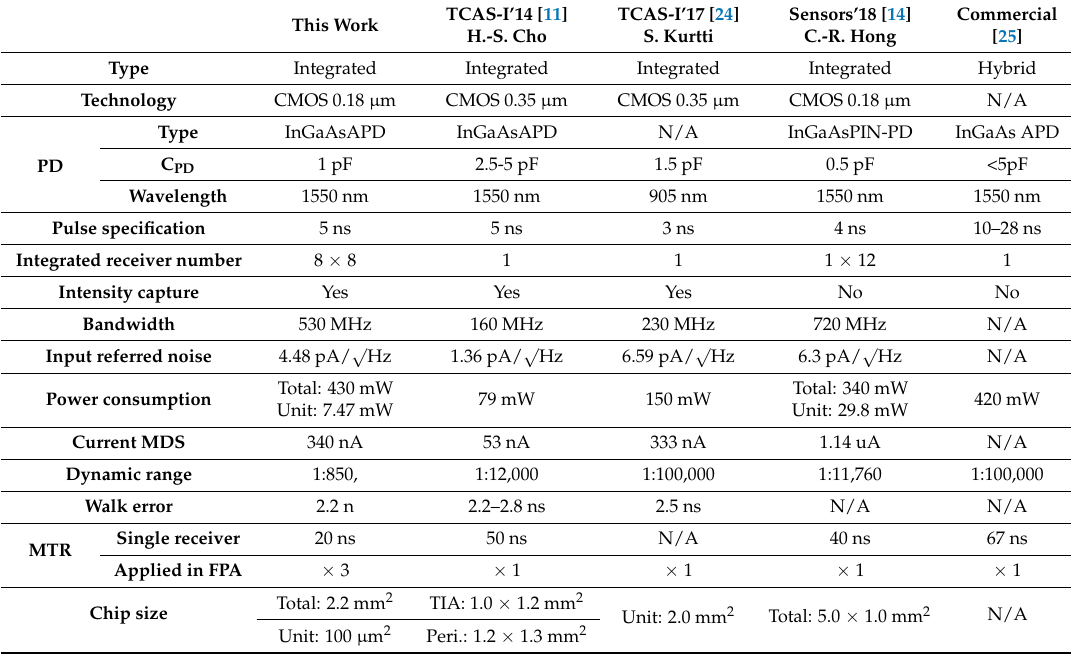
Table 1. Performance comparison.